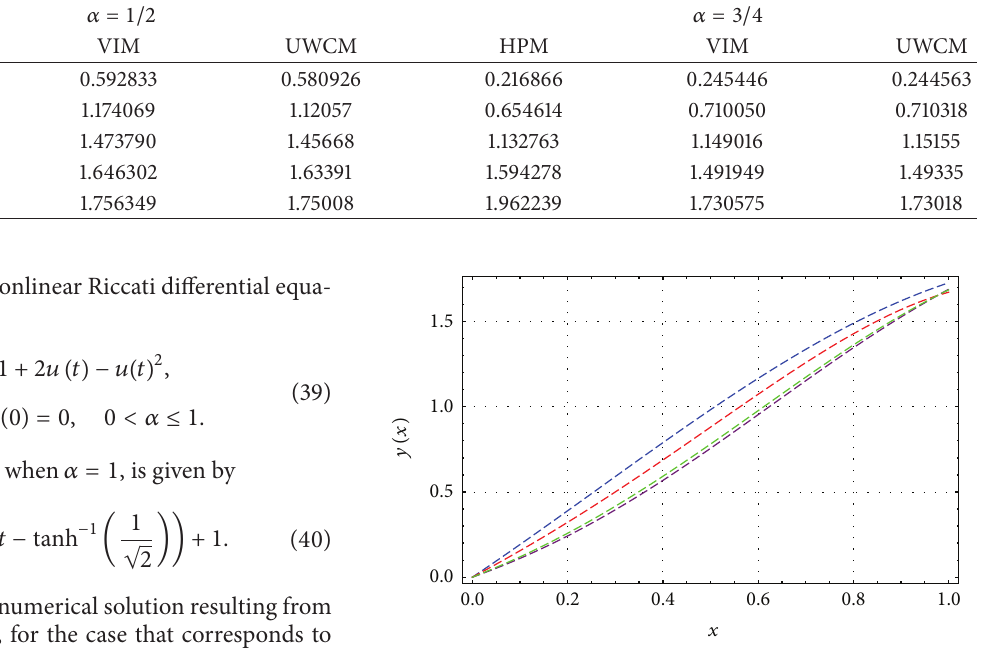
Table 2: Comparison between UWCM, HPM, and VIM for Example 8 for 𝛼 = 1/2, 3/4 .